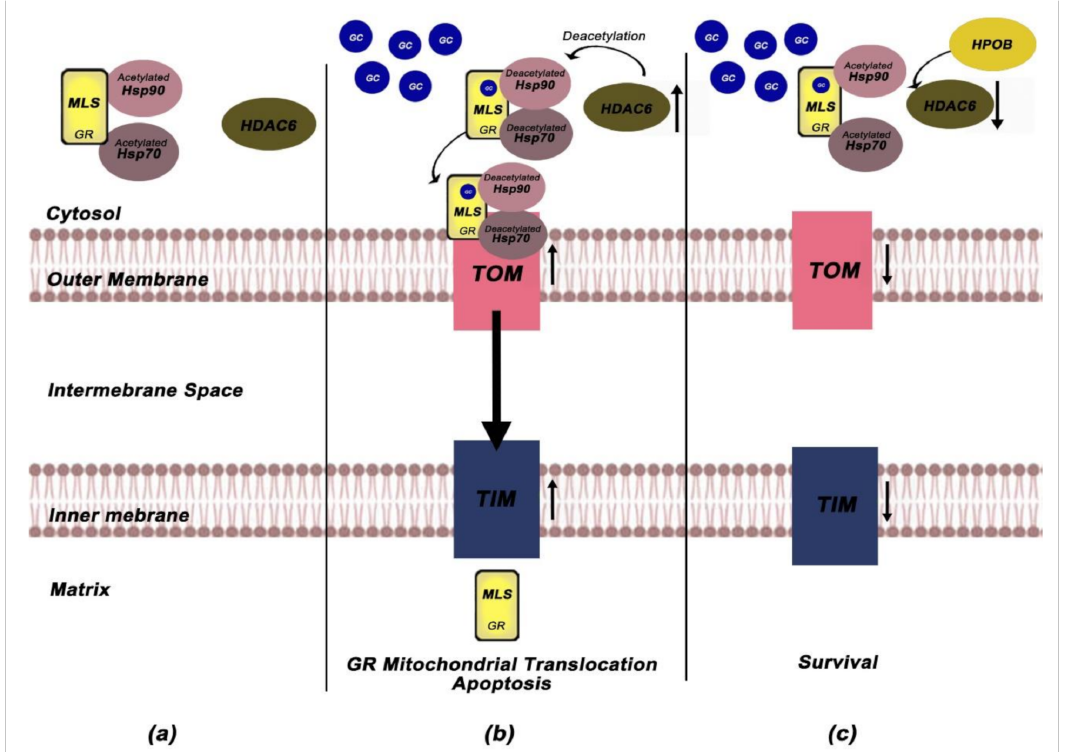
Figure 3. The involvement of HDAC6 and mitochondrial translocation machinery in GR import into mitochondria. ( a ) In unliganded state, GR is located into the cytoplasm complexed with low affinity to acetylated GR chaperones (Hsp70, Hsp90). ( b ) Cort treatment enhances the expression levels of HDCA6 and decreases the levels of Hsp90/70. HDCA6 triggers the deacetylation of Hsp70 and Hsp90, enhancing the affinity of GR complex for GC and favoring GR translocation into mitochondria. Cort also induces upregulation of the outer and inner membrane mitochondrial machinery (TOM and TIM), thus leading to GR import into mitochondria and inducing apoptosis processes. ( c ) HPOB treatment attenuates GR mitochondrial translocation through inhibiting HDAC6. HPOB triggers hyperacetylation of Hsp70 and Hsp90 and reverses the Cort-induced upregulation of HDCA6 and reduction of Hsp70 and Hsp90. Hsps hyperacetylation inhibits the binding between the multi-chaperone complex and Tom70, blocking the mitochondrial GR translocation and Cort-induced apoptosis [69,72]. GCs; Glucocorticoids, GR; Glucocorticoid Receptor, MLS; Mitochondrial localization signal, Hsp; Heat Shock Proteins, HDAC6; Histone Deacetylase